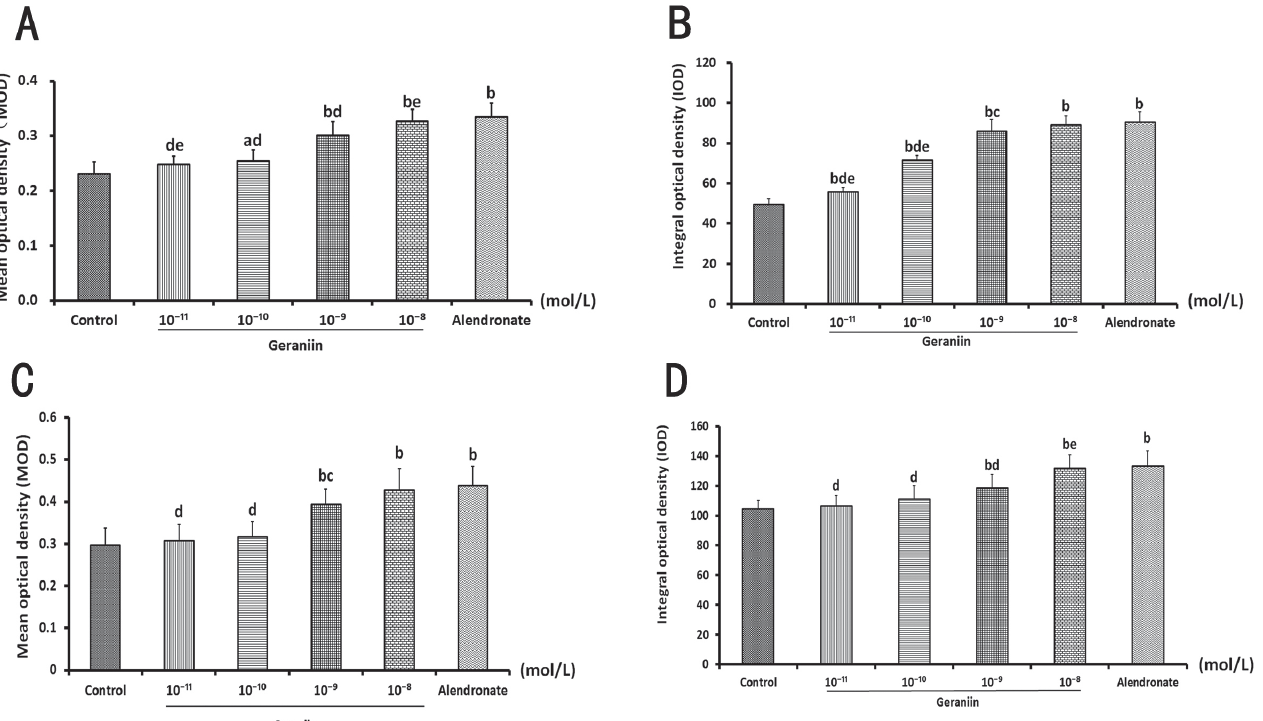
FIGURE 6 - Effect of geraniin on protein and mRNA expression of OPG in osteoblasts. Geraniin (10 -11 to 10 -8 mol/L) increased MOD (A) and IOD (B) values of OPG protein expression in positive cells. Geraniin (10 -11 to 10 -8 mol/L) concentration-dependently increased MOD (C) and IOD (D) values of OPG mRNA expression in positive cells. Values are mean ± S.D. a P < 0.05, b P < 0.01 versus control group, c P < 0.05, d P < 0.01 versus alendronate group, e P < 0.05 versus between geraniin (10 -11 to10 -8 mol/L) groups. One-way ANOVA followed by Student’s t